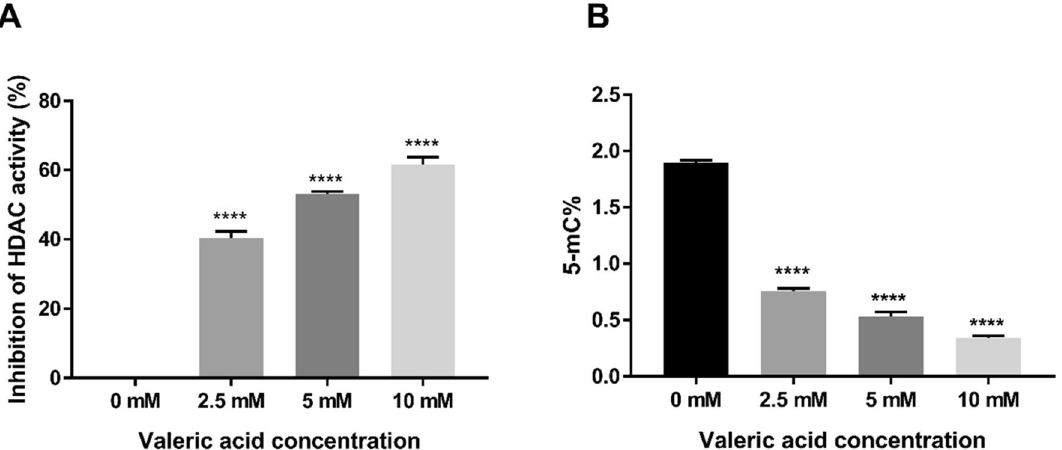
Figure 5. Impact of valeric acid on HDAC activity and global DNA methylation. ( A ) MCF-7 cells were incubated at three different concentrations of valeric acid and HDAC activity was measured after 48 h. Valeric acid significantly inhibited HDAC activity at concentration of 2.5 mM, 5 mM, and 10 mM compared to the control group (* p < 0.05). ( B ) The Global DNA methylation assay revealed that valeric acid (2.5 mM, 5 mM, and 10 mM) significantly decreased the levels of global DNA methylation in MCF-7 cells compared to the control group (* p < 0.05). All assays were performed in the network, 26 of which were significantly hypermethylated, while 1 of which was hypomethylated in treated cells. Several putative tumor related genes with oncogeneic role in breast cancer were hypermethylated, such as HDAC6, NASP, HNRNPC and LIN9 .